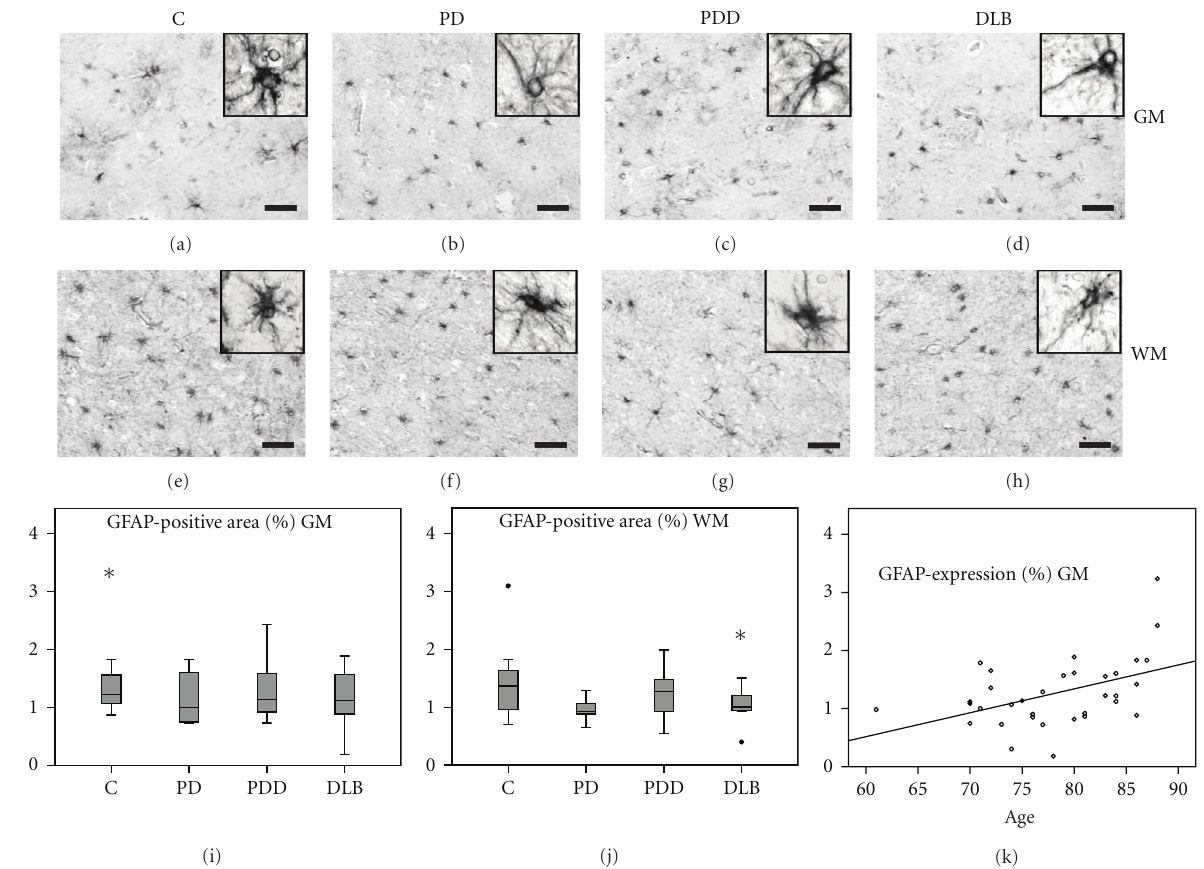
Figure 1: GFAP immunoreactivity in the human frontal cortex. (a–h) examples of GFAP immunoreactivity in grey (a–d) and white matter (e–h) of a 77-year-old female control (C) donor (NBB 2001-104; a, e), a 77-year-old male Parkinson’s disease (PD) patient (NBB 2005-069; b, f), a 71-year-old male Parkinson’s disease with dementia (PDD) patient (NBB 2004-045; c, g), and 76-year-old female dementia with Lewy bodies (DLB) patient (2001-025; d, h). (i-j) Boxplot of the quantification of GFAP staining in grey (i) and white matter (j) of 8 C, 6 PD, 11 PDD, and 9 DLB cases. (k) correlation of GFAP expression in the grey matter with age of the 34 donors. GM: grey matter; WM: white matter; inserts show higher magnification images of the same patients. Scale bars represent 50 μ m for the lower magnification and 20 μ m for the higher magnification